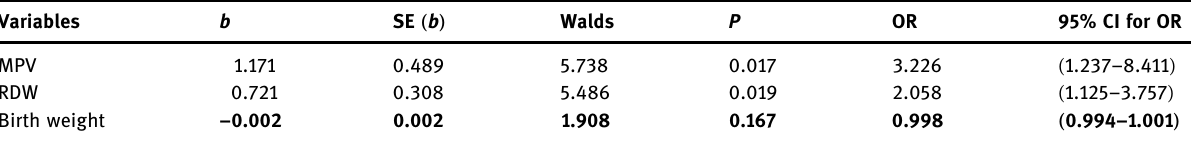
Table 4: Logistic regression analysis results Variables